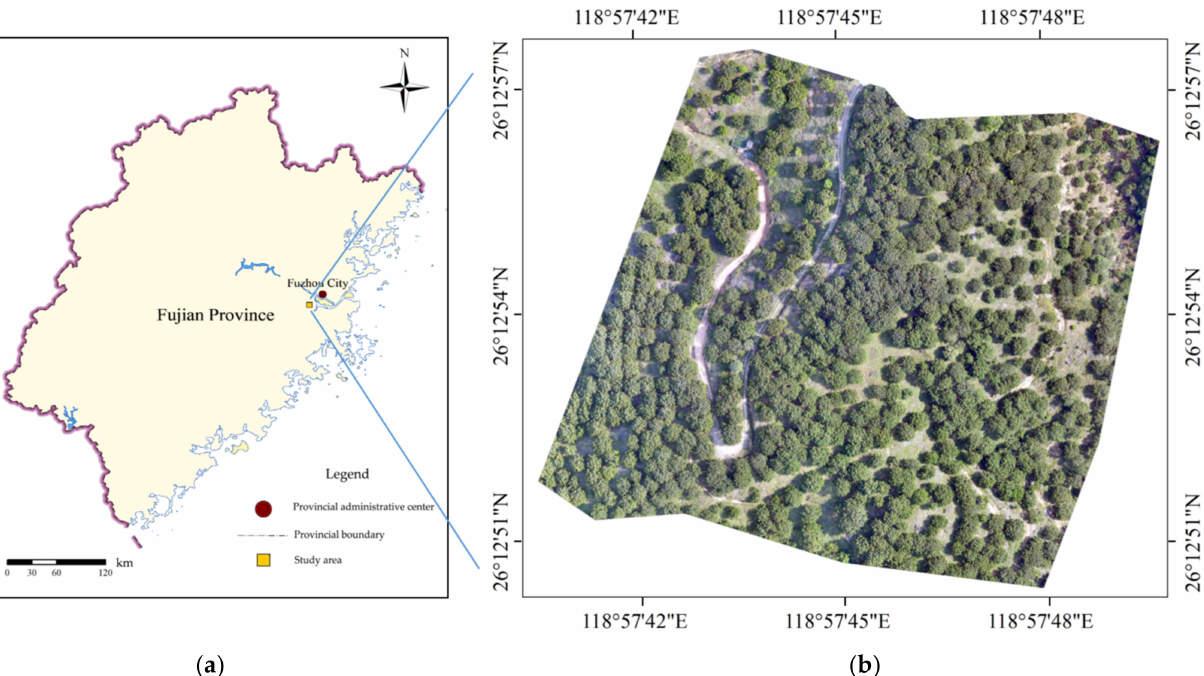
Figure 1. Geographic location of the study area: ( a ) administrative map of Fujian Province, China; ( b ) orthophoto of the study area taken by